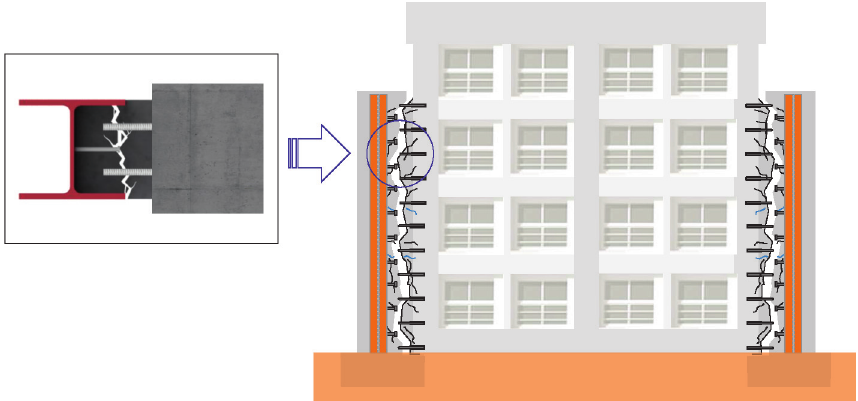
Figure 1: Drawbacks of the conventional chemical lap-splicing method (i.e., cracks in the concrete surface), which uses a steel rebar for connecting existing reinforced concrete (RC) frames to external strengthening elements.